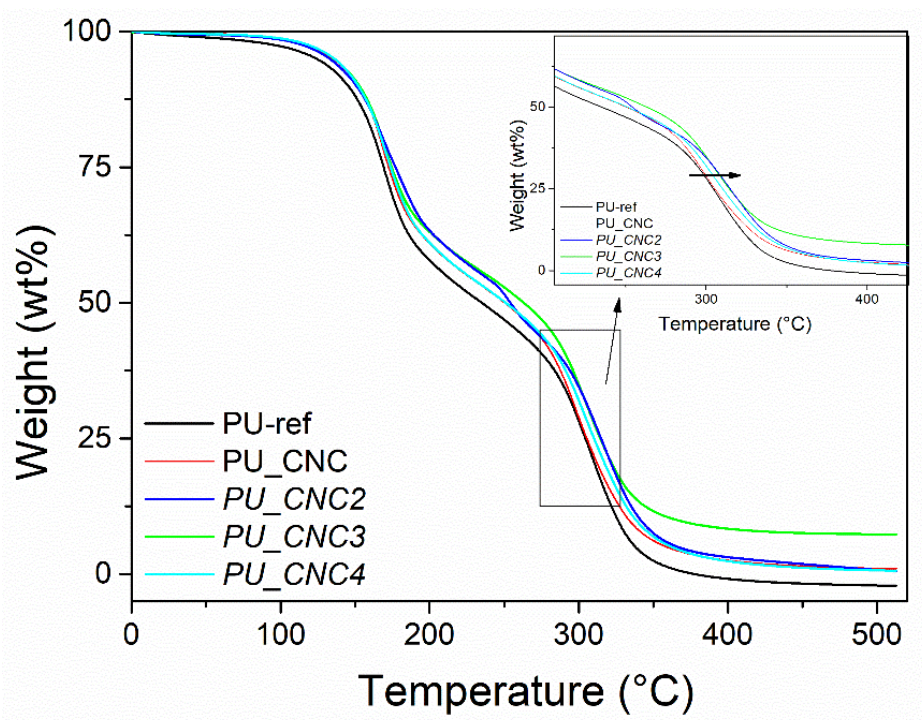
Figure 7. TGA of PU reference and of PU with 3 wt% of pristine CNC, 3 wt% of CNC1, 3 wt% of CNC3 and 3 wt% of CNC4.